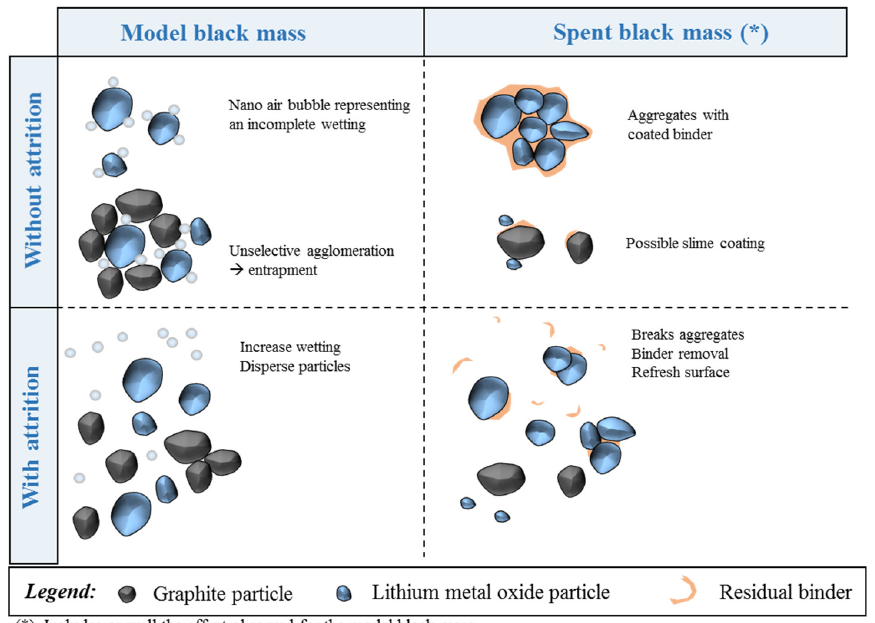
Figure 10. Summary of the potential effects of attrition on the black mass. (*) the effects observed in the model black mass are also included in the spent black mass.